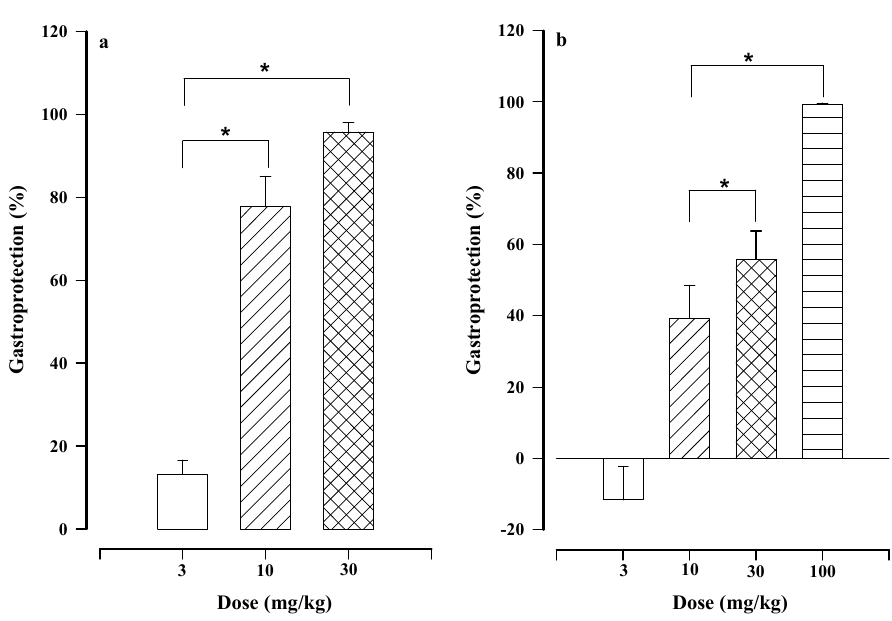
Figure 2. Gastroprotective effect of calein D ( a ) and carbenoxolone ( b ). Bars represent the mean ± SEM ( n = 7). * p < 0.05, based on the Kruskal − Wallis test followed by Dunn’s multiple comparison.